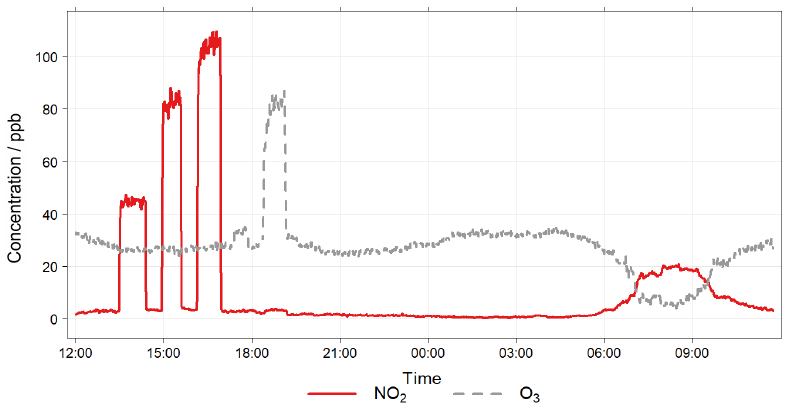
Figure 7. EASE calibration setup example concentrations, note the artificial spikes from 12:00 to 21:00, and morning rush hour period from 06:00 to